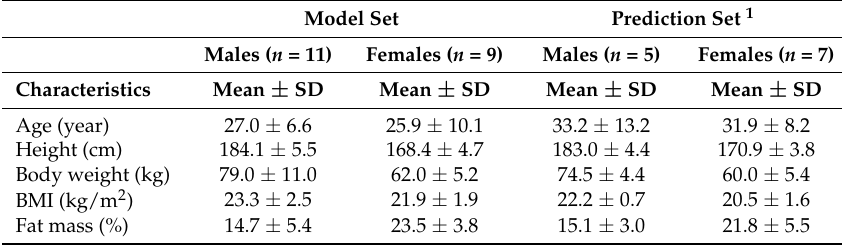
Table 1. Demographic characteristics of volunteers ( n = 32).